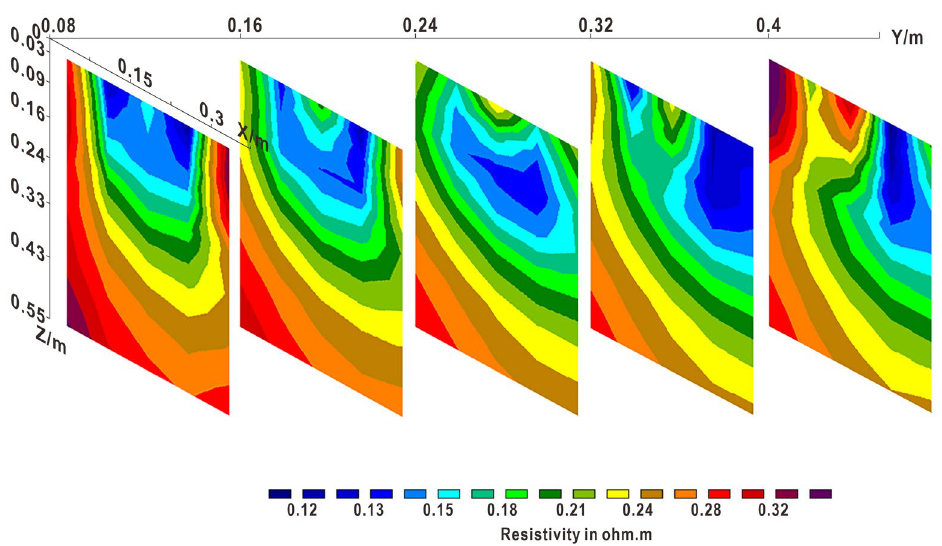
Figure 10. X–Z longitudinal section on different Y